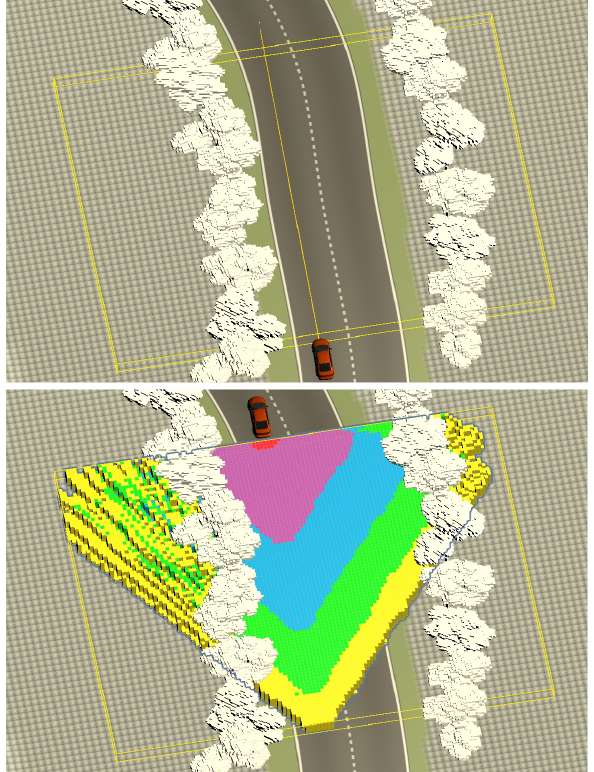
Figure 9. Visibility analysis of a driver. Top image - the vehicle trajectory and AoI; bottom image - the 3D visibility